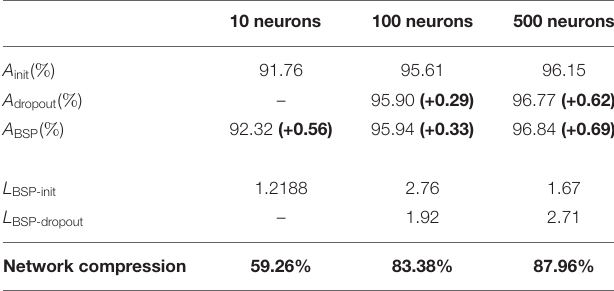
10 neurons 100 neurons